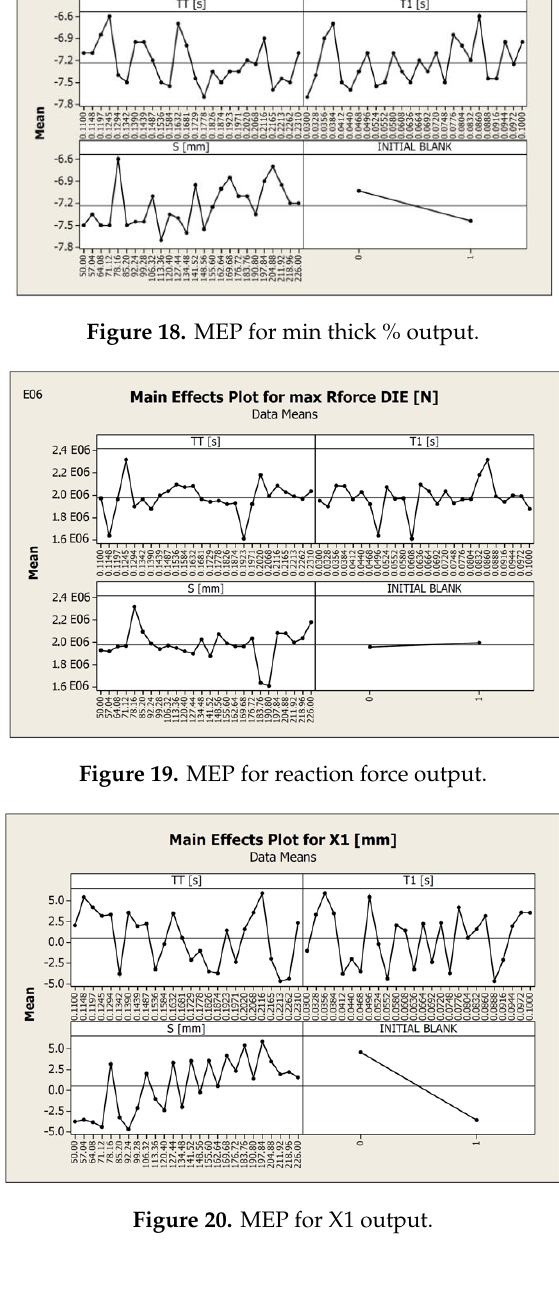
Figure 21. MEP for X2 output.